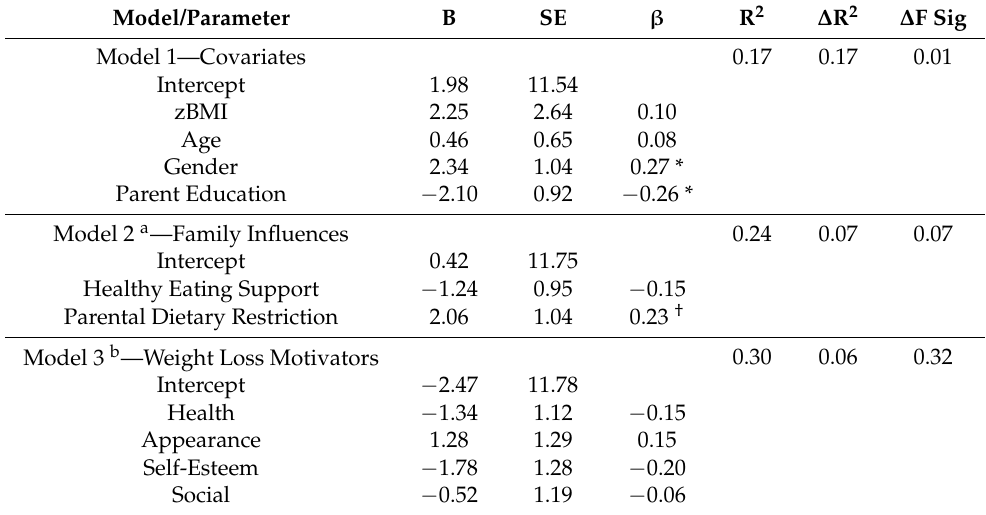
Table 5. Regression analyses assessing associations of family factors and weight loss motivators with sweetened beverage